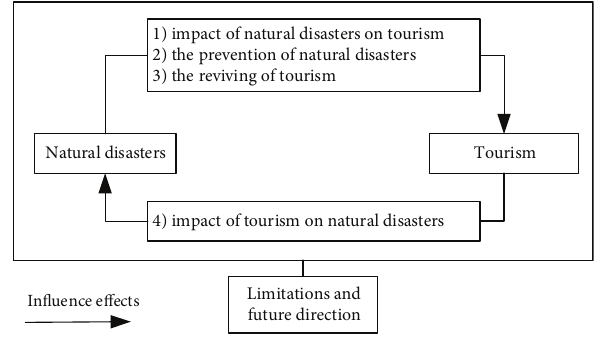
Figure 9. The framework of the theme